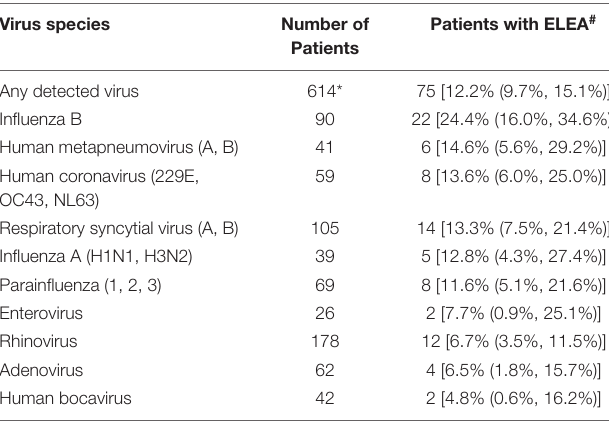
TABLE 3 | Viruses detected in the whole sample and proportion of patients with elevated serum enzyme activities (ELEA) at visit 1. Virus species Number of Patients with ELEA Patients